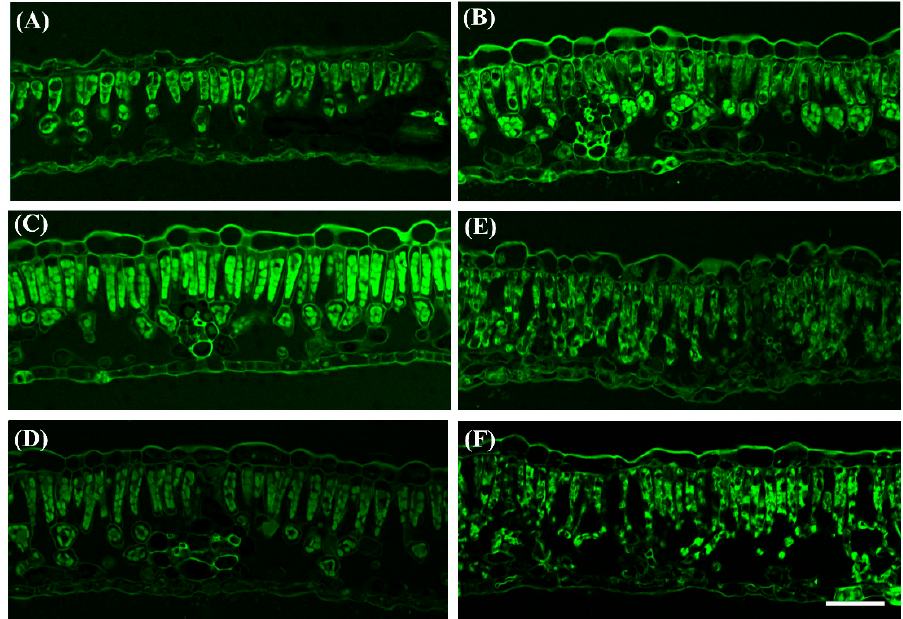
Figure 2. Leaf cross-section structures analysis in healthy plant leaves (CK, A ), the mosaic leaves ( B ), the green leaves G1( C ) and G2 ( D ), and yellow leaves Y1 ( E ) and Y2 ( F ) of PMV-infected plants. Bars = 20 μ